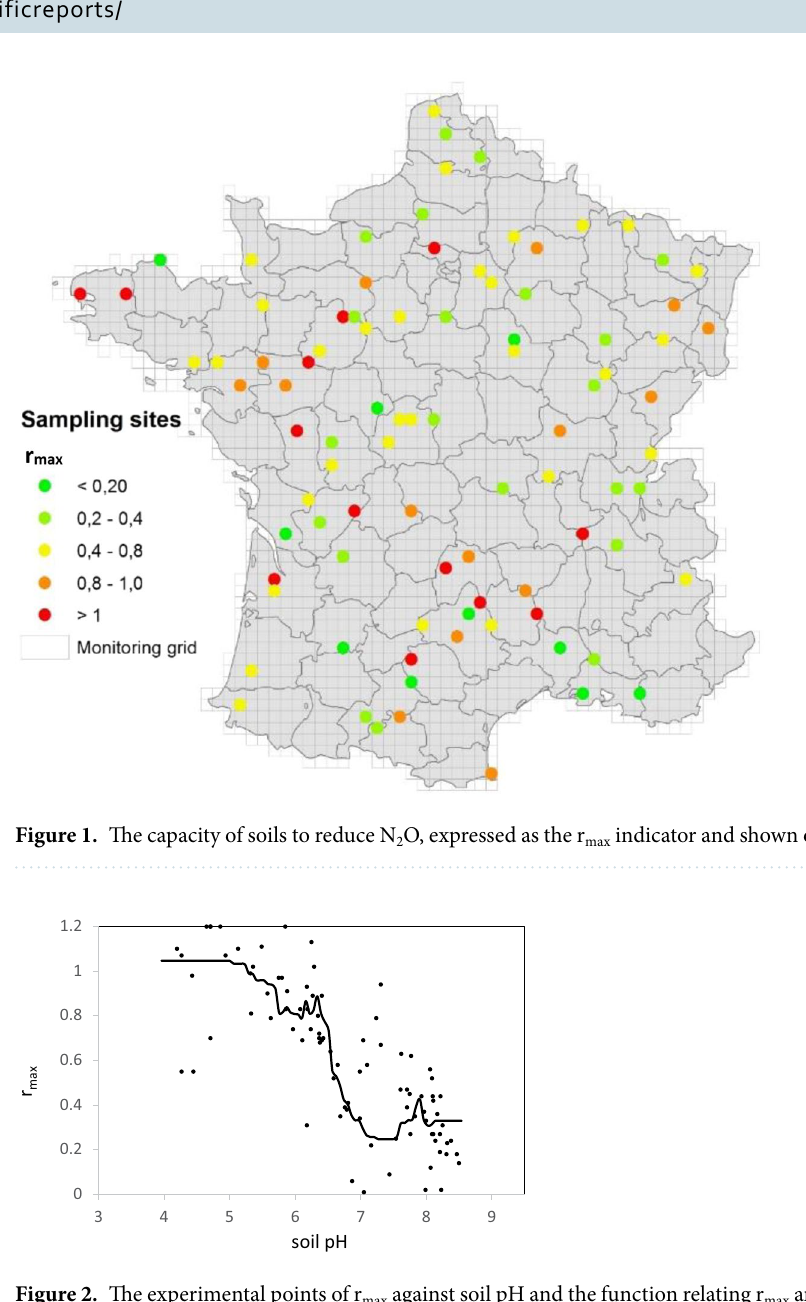
Figure 2. The experimental points of r max against soil pH and the function relating r max and soil pH obtained by the